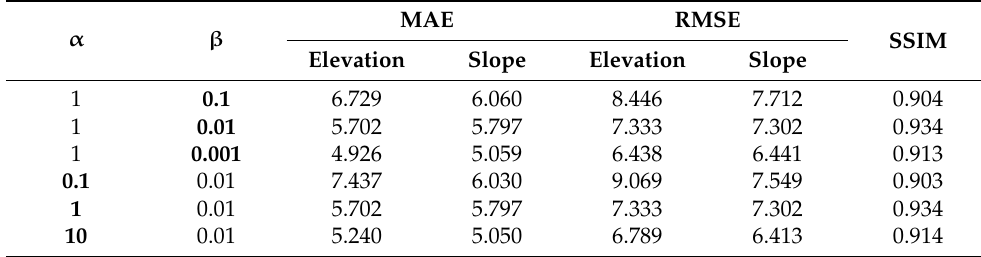
Table 4. Results of our method (GISR) with different parameter settings (baseline: α =1 and β = 0.01).